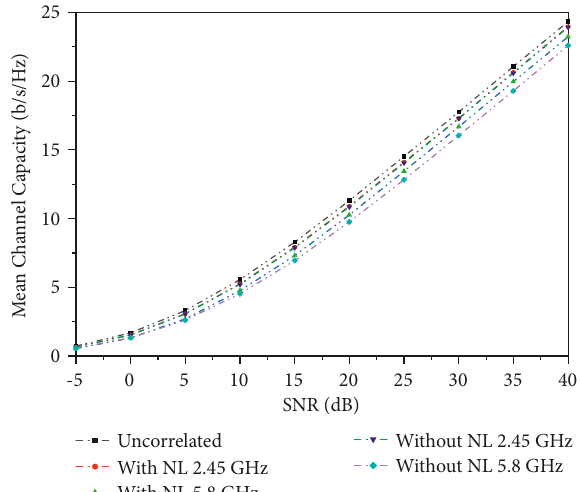
Figure 19: The mean channel capacities of antenna#2 with and without